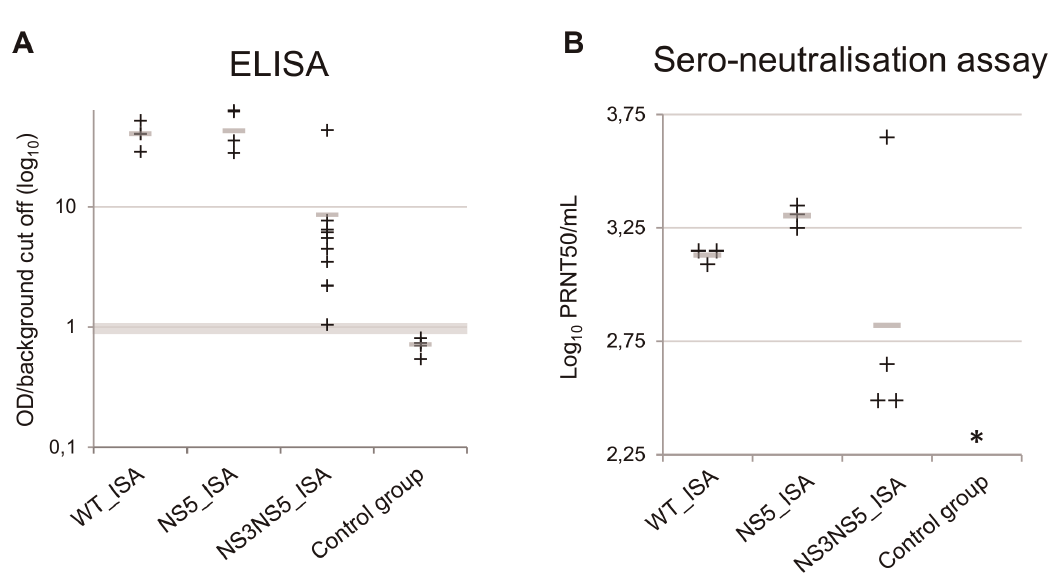
Fig 4. Results of TBEV serology at day 43 post-inoculation. ELISA (A) and sero-neutralisation assays (B) . Black crosses represent each individual value. Grey bars represent mean values. For ELISA tests, ratios were calculated as follows: OD/background cut off (mean of OD for control group + (3 x SD of OD for control group)). Samples were considered as positive if the ratio was higher than 1.1, negative if under 0.9 and uncertain if between 0.9 and 1.1 (grey zone). * All the sera of the control group tested were negative ( e . g . under the detection threshold of the method (2.25